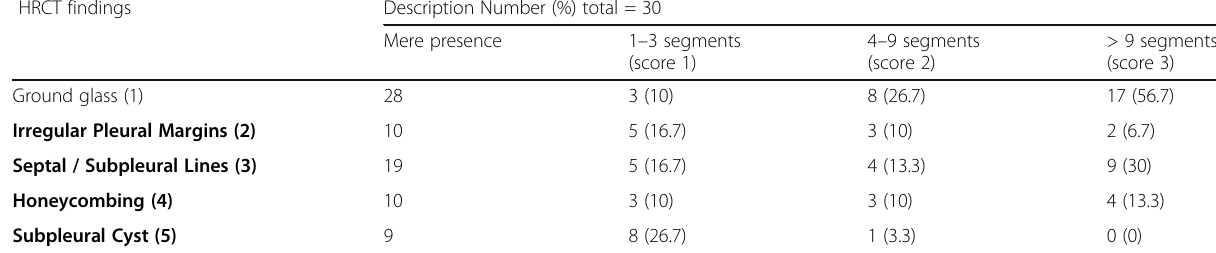
Table 4 Description of extent and severity score findings HRCT findings